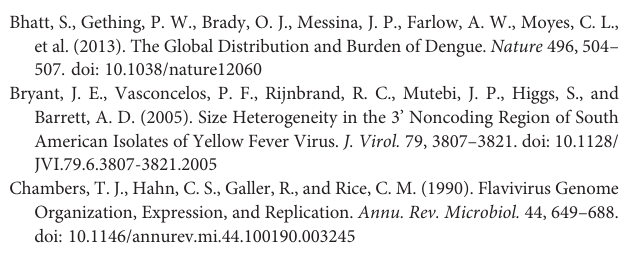
Supplementary Table 1 | The serotype distributions of DENV strains in 2019 by PCR. Supplementary Table 2 | Information of reference sequences. Supplementary Table 3 | P-value of recombination analysis. Supplementary Table 4 | Padj-value of recombination analysis.